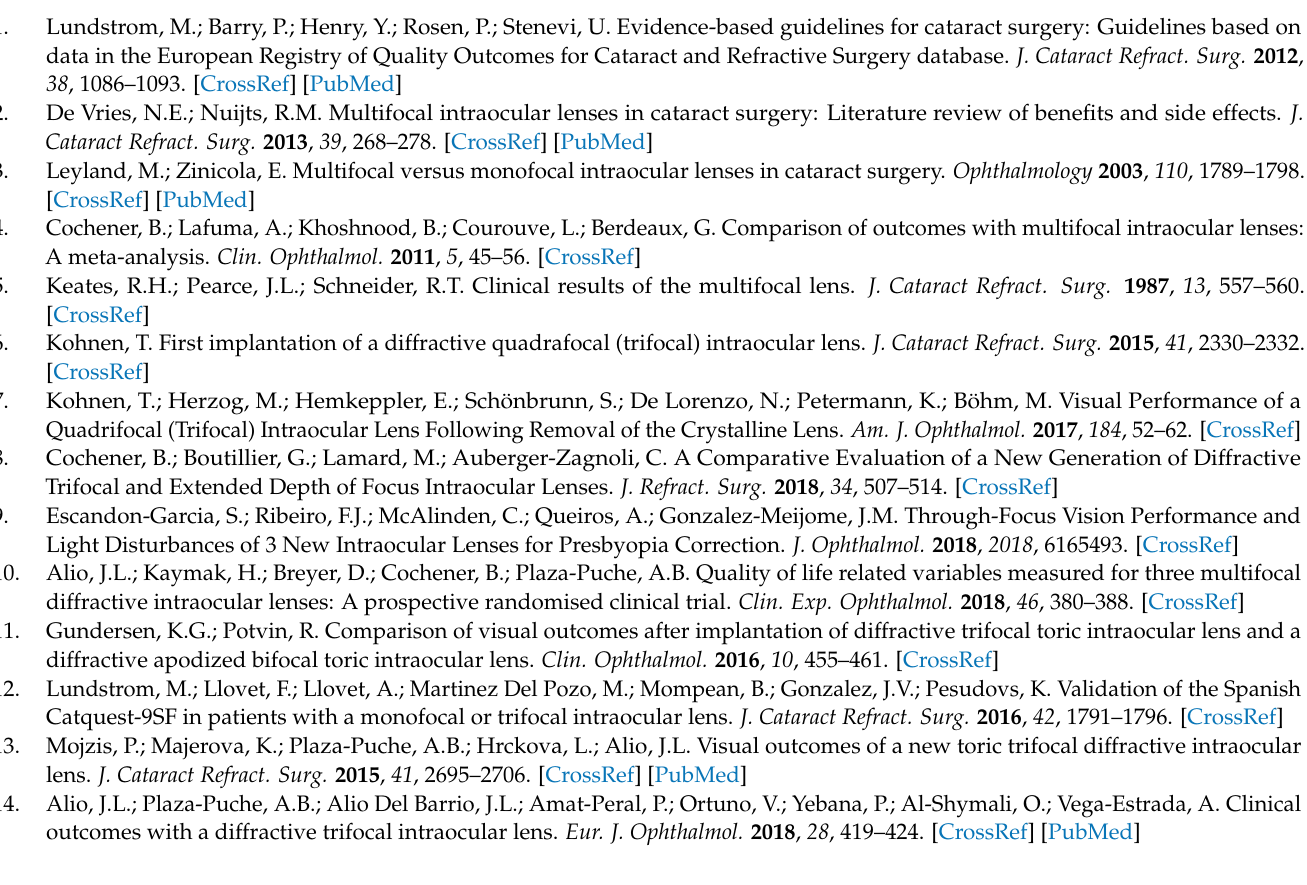
Figure A2. All patients’ answers to questionnaire (Q3–Q19, represent various daily tasks), which explores difficulties in performing different activities of daily life.